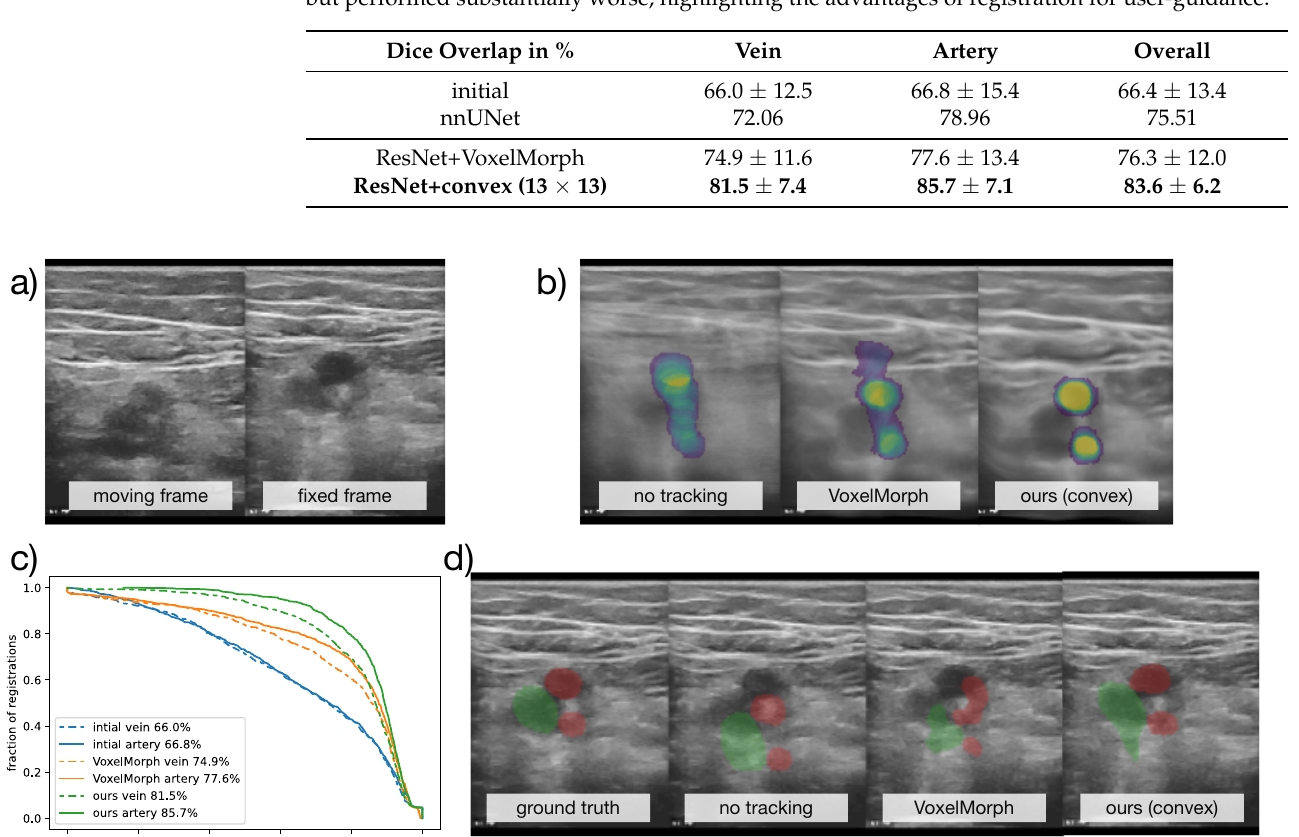
Table 2. Quantitative evaluation for the CoCoAI dataset . We compared the quality of segmentation propagation using motion estimation of our proposed registration approach against the best ResNet- VoxelMorph baseline. Both were trained with only centre point annotations of vessels. In addition, we also evaluated a segmentation model (nnUNet) that was trained on the full pixelwise annotation, but performed substantially worse, highlighting the advantages of registration for user-guidance.